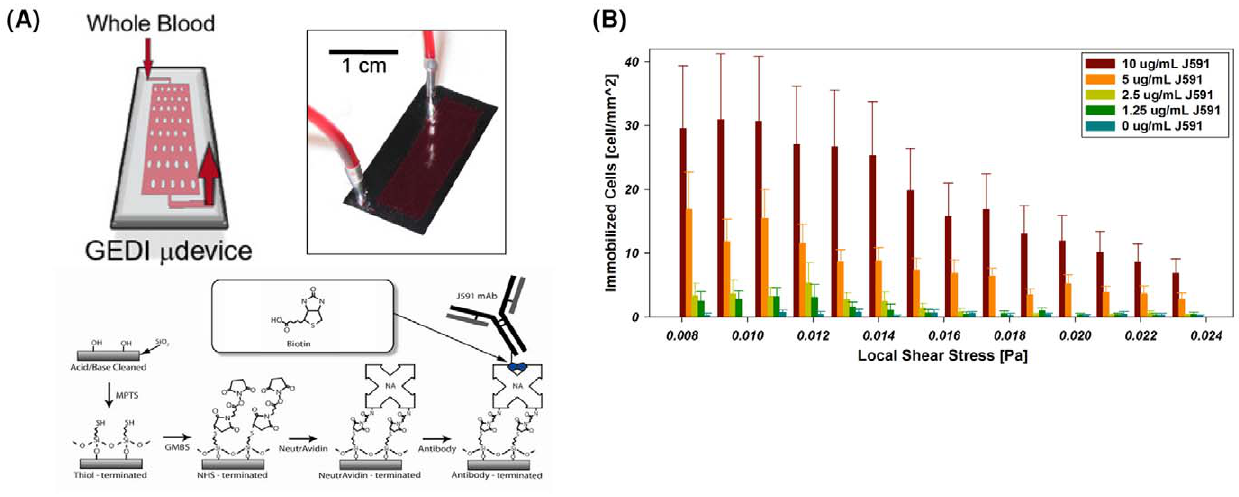
Figure 1. GEDI microfluidic device design. (A) GEDI device overview. Clockwise from upper left: schematic of blood flow through device, image of silicon device with silicone gasket, surface functionalization scheme. (B) Cell capture performance as a function of shear stress and antibody concentration. Titration curves for the anti-PSMA J591 antibody in a standardized geometry indicate optimal antibody concentration for cell capture.